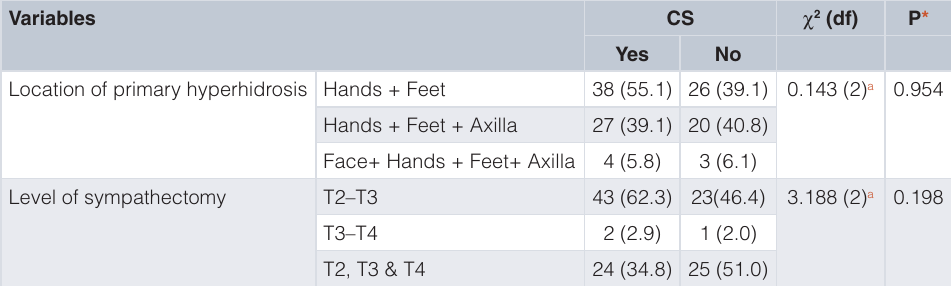
Table 7. Association between location of primary hyperhidrosis (PHH), level of sympathectomy and compensatory sweating in 118 patients following endoscopic thoracic sympathectomy.